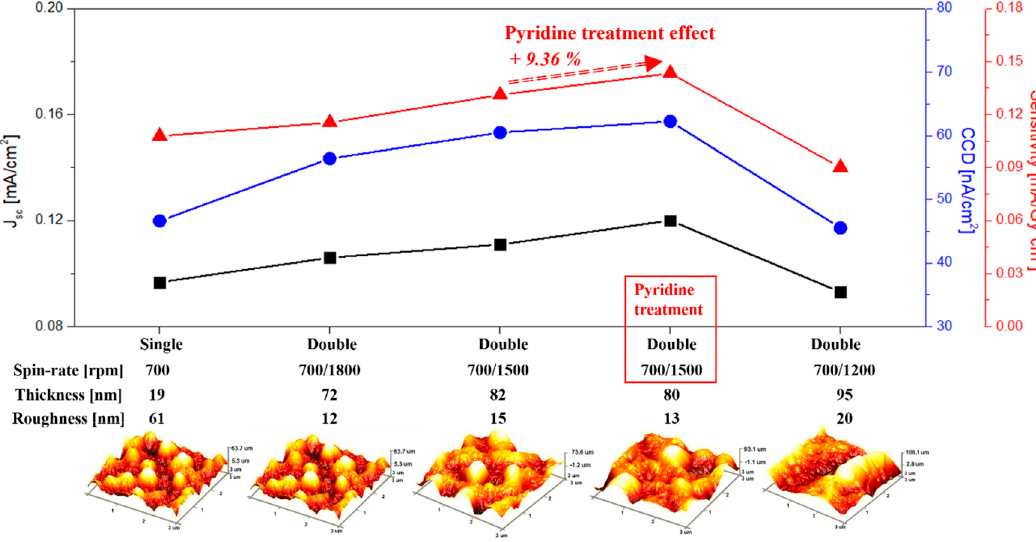
Figure 10. X-ray parameters (CCD and sensitivity), short-circuit current density (J sc ), thickness of the active layer, and surface roughness of the active layer, depending on the spin-coating and pyridine treatment conditions.